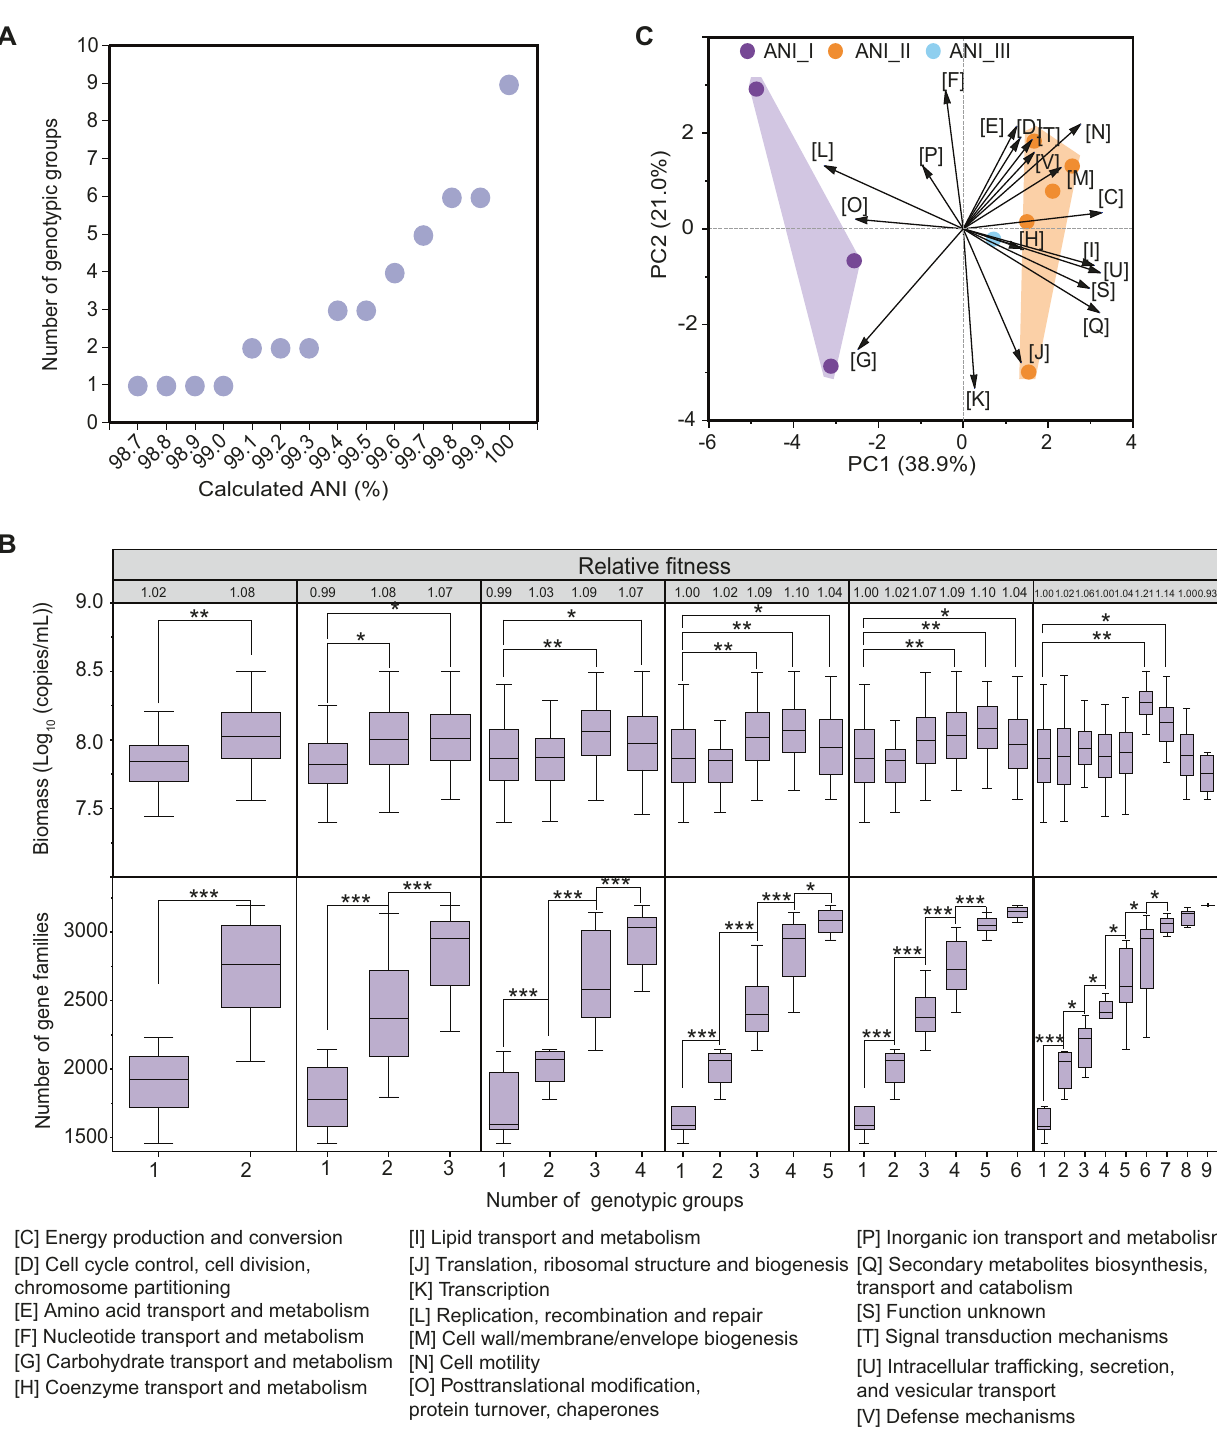
Fig. 2 Effect of strain classi fi cation method on intraspeci fi c interactions of L. acetotolerans . A Classi fi cation of genotypic groups of L. acetotolerans under different ANI levels. The lowest ANI level among 9 isolates was 98.7%. B Relative fi tness, biomass (qPCR) and number of gene families in mono- and cocultures of different genotypic groups in 6 classi fi cation methods according to different ANI levels. Difference of biomass in 95 trials containing 9 monocultures and 86 cocultures (Supplementary Table 2). Cultures were performed in 1.5 mL of chemically de fi ned medium in 96-well plates under static and anaerobic conditions at 30 °C for 8 days. Error bars indicate the standard deviation from four biological replicates. Asterisks indicate signi fi cant differences of biomass and number of gene families in coculture and monoculture ( t - test, * p < 0.05, ** p < 0.01, *** p < 0.001). C The variation in the gene contents of all COG categories in three ANI groups (classi fi ed by 99.5% average nucleotide identity) compared by principal component